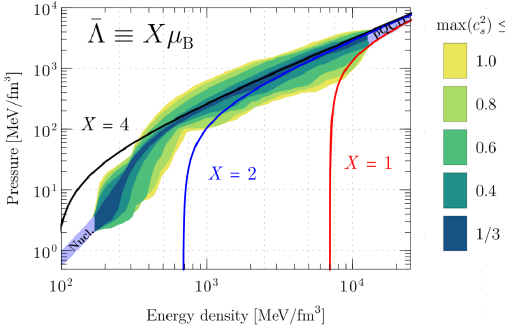
Figure 1. An illustration of the renormalization-scale dependence of the cold-QM EoS at N2LO [7]. The cold-QM EoS is shown for the three di ↵ erent choices of the renormalization parameter X = 1 , 2 , 4, plotted on top of the regions of viable NS-matter EoSs as determined in Ref. [9] using robust theoretical and astrophysical constraints. These regions are color-coded by the maximal value of the speed of sound squared c 2 obtained at any point along the EoS, with lower max( c 2 s